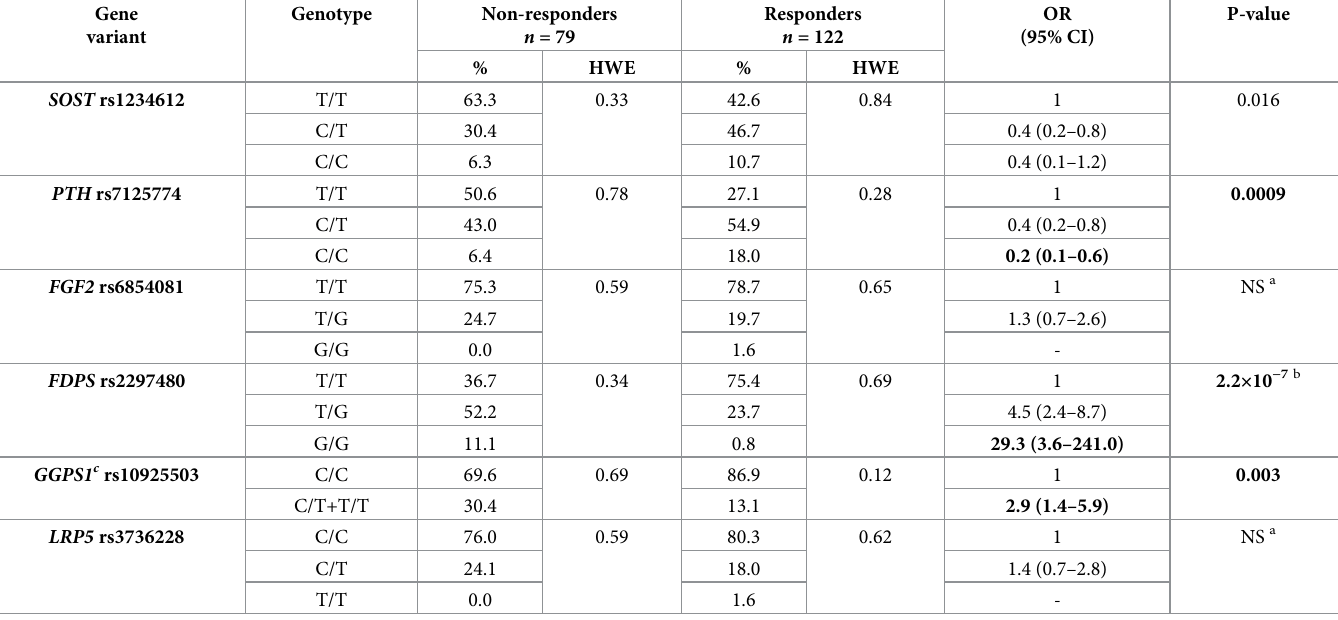
Table 2. The Hardy-Weinberg equilibrium (HWE) P-values and distribution of genotype frequencies of SOST , PTH , FGF2 , FDPS , GGPS1 , and LRP5 gene variants in responders and non-responders. Gene